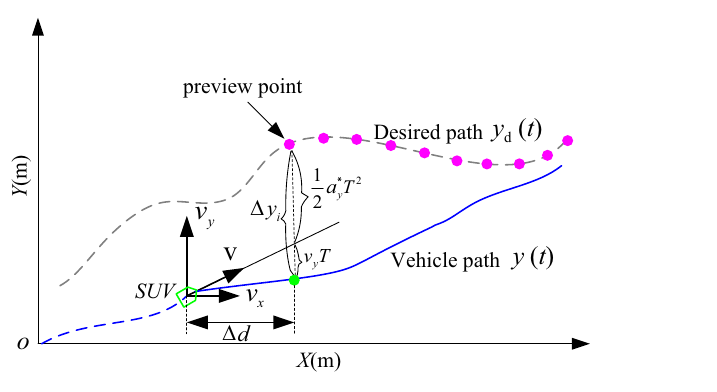
Figure 4. Preview-follower